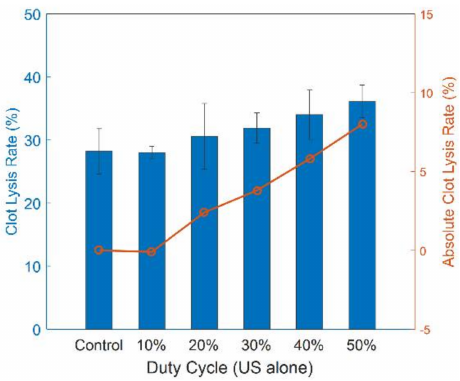
Figure 9. In vitro US alone experiment result. Clot lysis vs. duty cycle ( n = 3, US settings of 1.1 MHz, 50 V pp input voltage, 500 PRF, 60 min treatment).